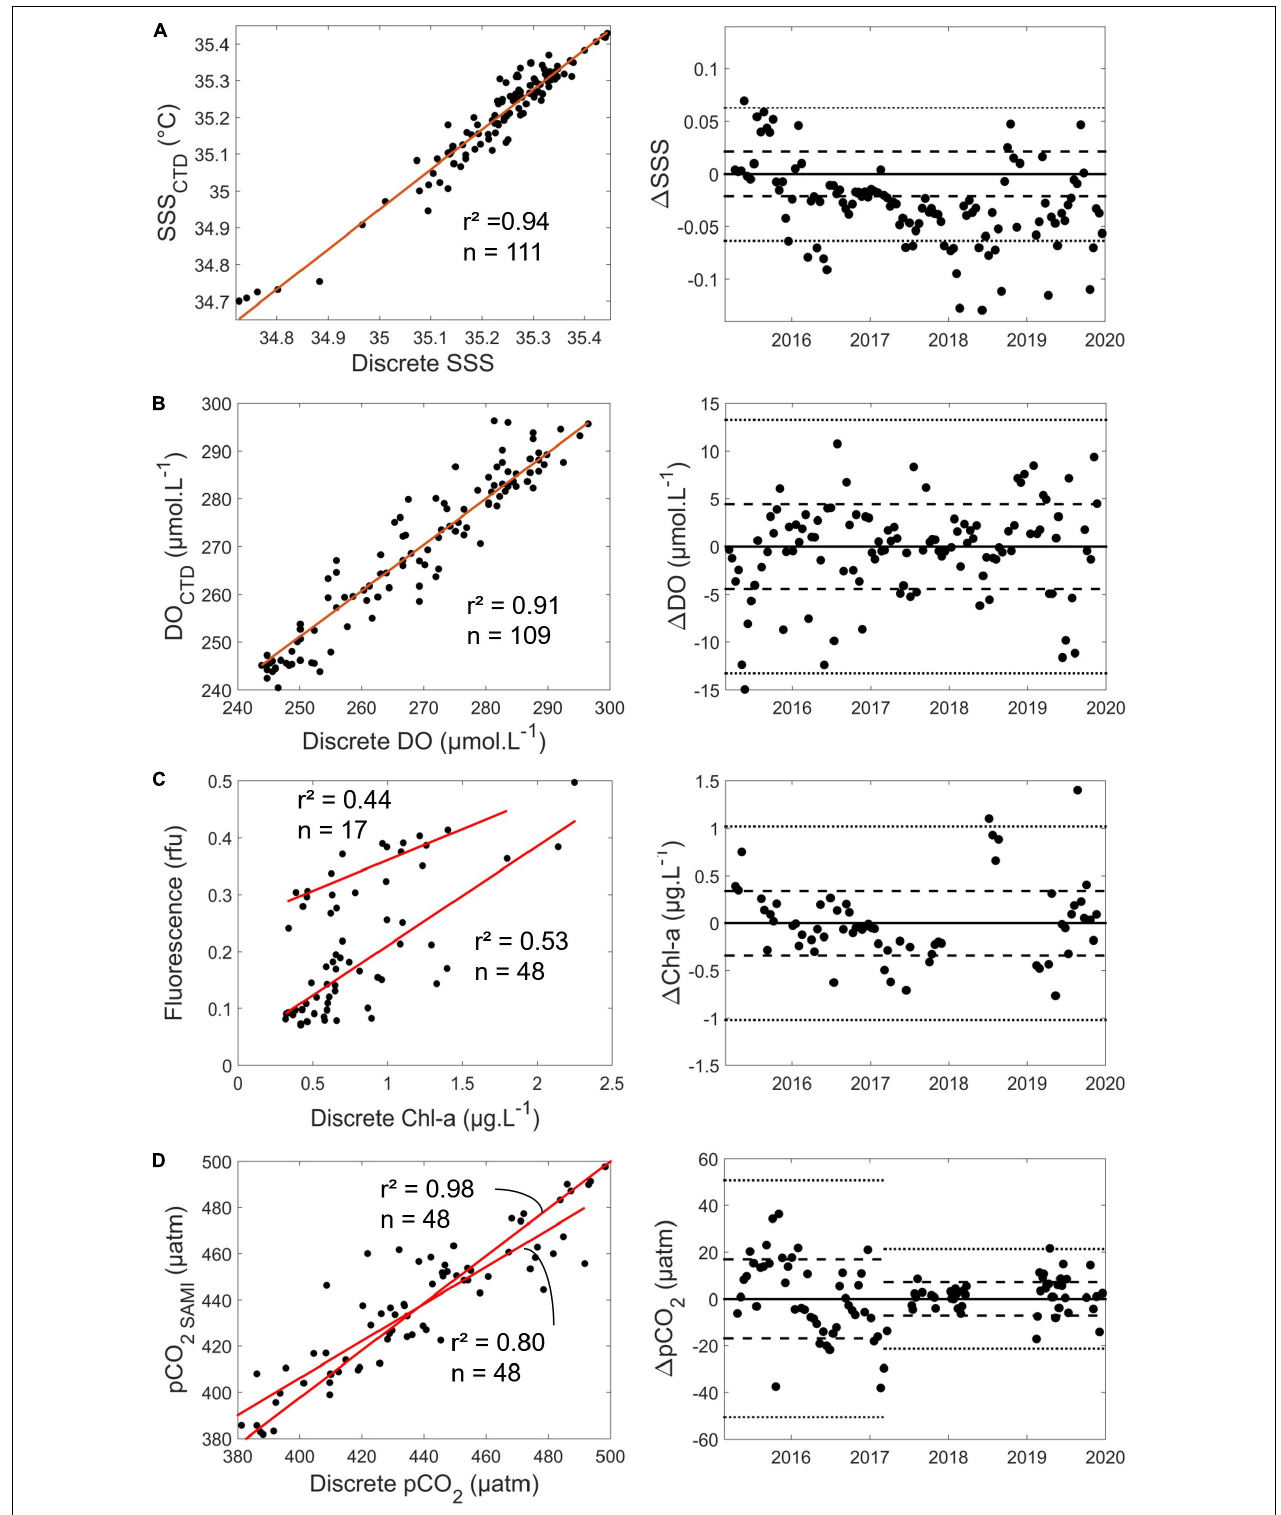
FIGURE 2 | Correlations between HF and discrete data for (A) SSS, (B ) DO ( µ M), (C) Chl-a ( µ g L − 1 ), and (D) pCO 2 ( µ atm). Left plots show discrete measurements versus sensor values, with n the number of discrete measurements, red lines the linear regression between discrete and sensor measurements and associated r 2 values. The right plot shows the differences between sensor values and discrete measurements over time. Dashed lines represent standard deviation of the difference between sensor values and discrete measurements, and dotted lines represent three times the standard deviation.